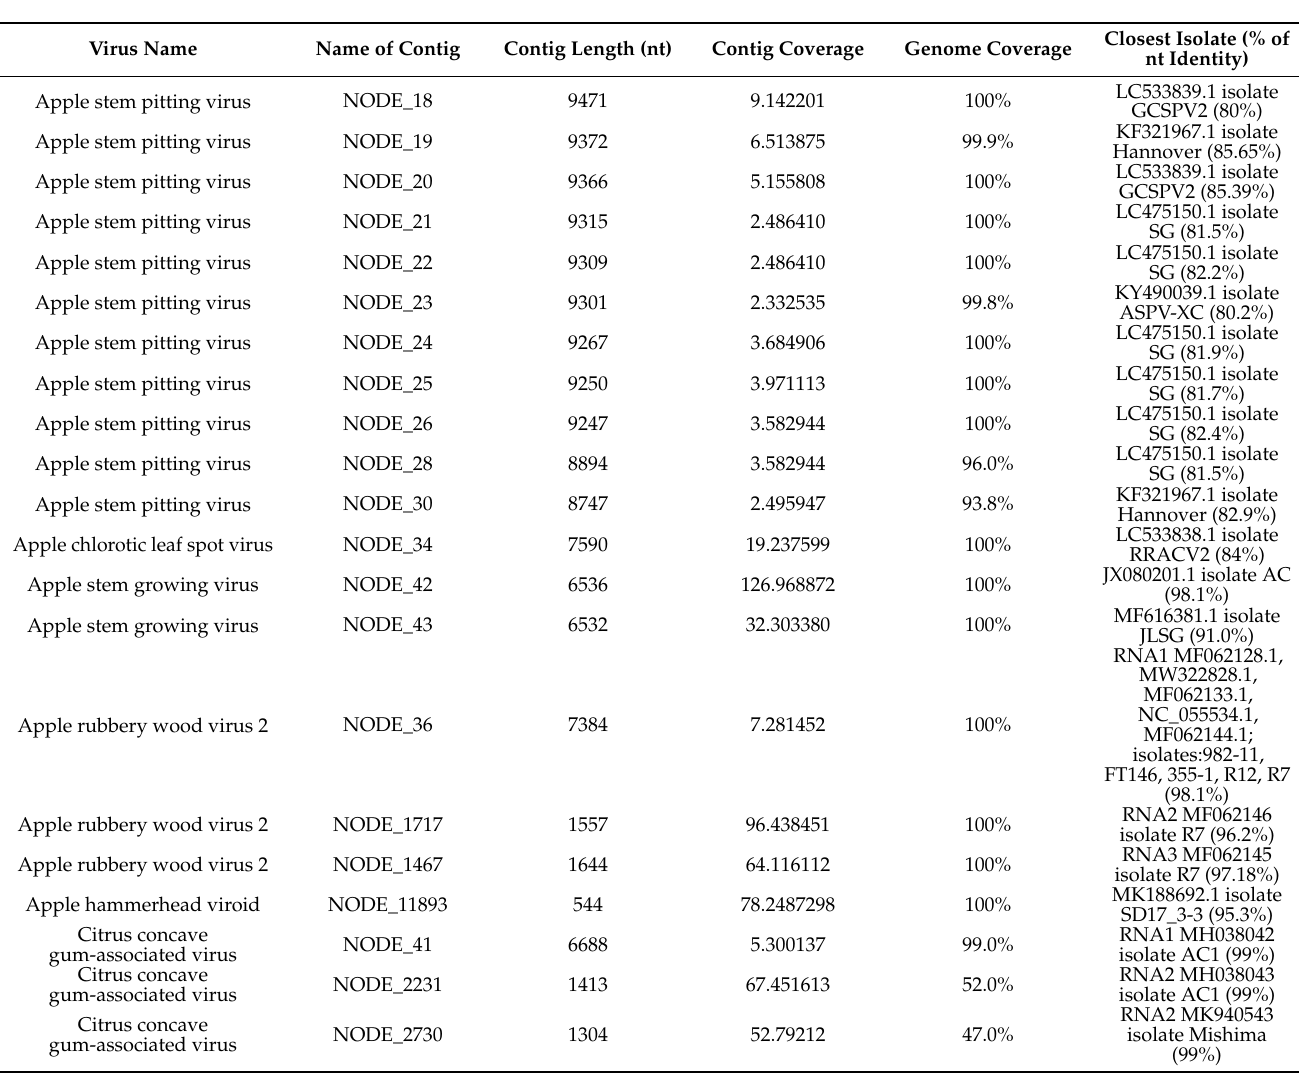
Table 5. Assembled contigs corresponding to full-length or almost-full-length genomic sequences of known viruses in the